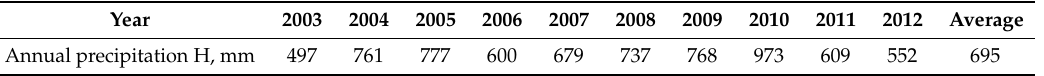
Table 1. The amount of rainfall in the years 2003-2012 for Rzesz ó w city.